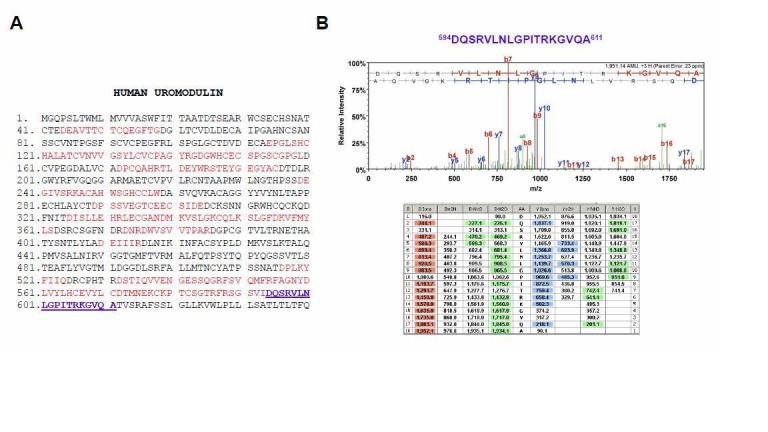
Mass spectrometry analysis of the long uromodulin isoform released by MDCK cells.(A) Mass spectrometry sequence coverage (42%) of Asp-N-digested human uromodulin (long isoform) from the medium of stably expressing MDCK cells. The analysis was carried out as described in the Methods section of the manuscript. The long isoform was separated in 2D electrophoresis. Matching peptides are shown in red, while the C- terminal peptide is shown in blue. This peptide ends at A611, a distal C-terminal relative to the one identified for the short isoform (F587) that is identical to the one reported for human urinary uromodulin (Santambrogio et al., 2008). (B) Representative tandem mass-spectrometry (MS/MS) spectrum confirming the identity of the 594DQSRVLNLGPITRKGVQA611 C-terminal peptide of the long uromodulin isoform released by MDCK cells and table of fragmented ions.